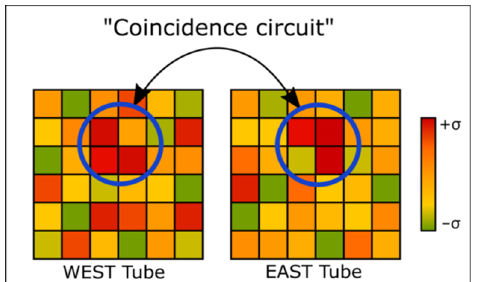
Figure 4. The illustration of the matching method for the twin-telescope MASTER. Only those events in a given direction are counted that simultaneously appear on both pipes in the form of three connected pixels, in each of which, the signal exceeds 1